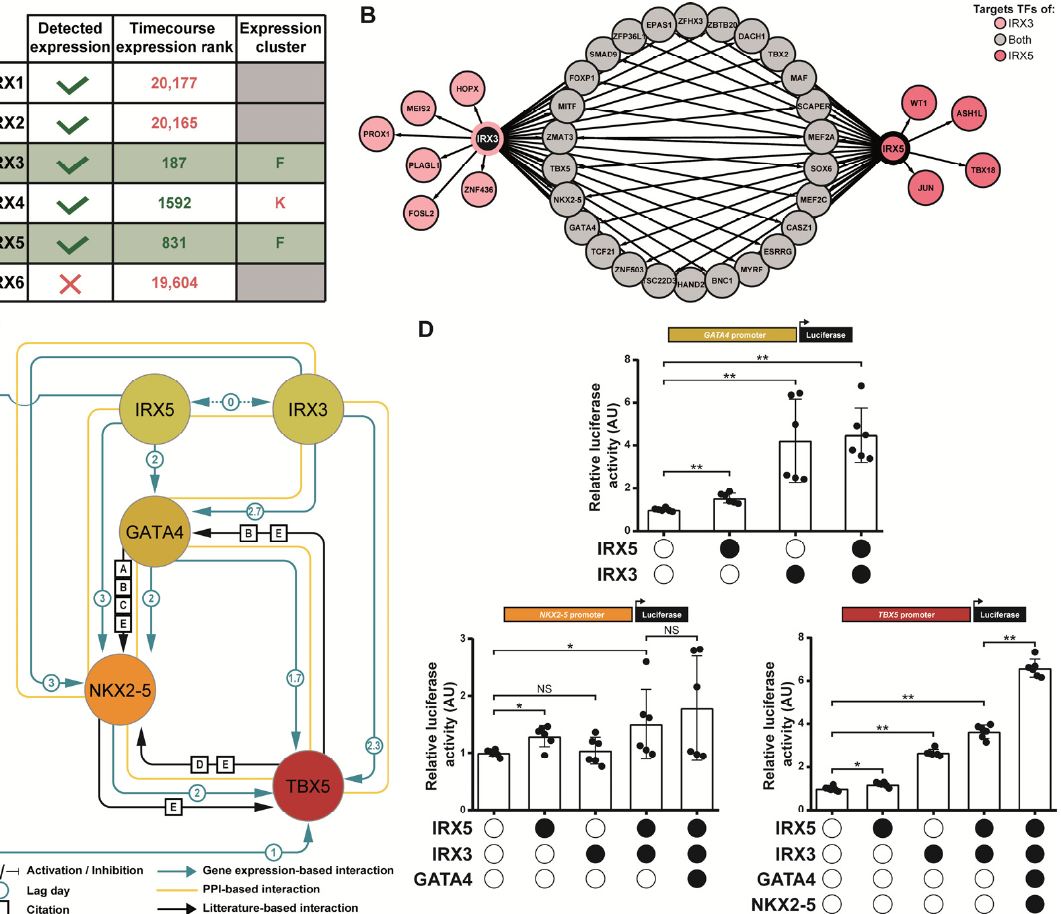
Figure 5. Exploration of the inferred IIGNT sub ‐ network. ( A ) Table of TF selection criteria for the IRX genes family. Timecourse expression rank is the output of the timecourse package and illustrates the variation in gene expression during directed cardiac differentiation (a lower number indicating a higher variation). The Expression cluster column refers at the expression cluster in which each TF ranged as in Figure 4A. Selection and exclusion criteria are indicated in green and red re ‐ spectively. ( B ) Potential target TFs of IRX3 and/or IRX5 identified in the G ‐ to ‐ L clusters based on the gene expression ‐ based network. ( C ) Gene expression ‐ based network of IRX3, IRX5, GATA4, NKX2 ‐ 5 and TBX5 TFs. Node colors represent their corresponding clusters as in Figure 4A: IRX3 and IRX5–cluster F; GATA4–cluster G; NKX2 ‐ 5–cluster I; TBX5–cluster L. Lag is shown in days. References to literature ‐ based links: [A] Book chapter DOI: 10.1016/B978 ‐ 0 ‐ 12 ‐ 381332 ‐ 9.00027 ‐ X.; [B] PMID: 23457256; [C] PMID: 22449847; [D] PMID: 32450132; [E] PMID: 25280899. ( D ) Graphs displaying activity levels of luciferase that is under the control of GATA4 ( ‐ 1800_TSS_+200), NKX2 ‐ 5 ( ‐ 2000 bp_Start codon) and TBX5 ( ‐ 1800_TSS_+200) promoter constructs. Mean +/ ‐ SD; * and **: p < 0.05 and p < 0.01, respectively (Mann ‐ Whitney test). In order to investigate the role of IRX3 and IRX5 in cardiac differentiation progres ‐ sion, all their potential TF targets in the subsequent G to L clusters were extracted from the gene expression ‐ based network (Figure 5B). Interestingly, this analysis revealed pre ‐ viously unknown regulatory links between cardiac TFs. Indeed, the master cardiac TF genes GATA4 (cluster G), NKX2 ‐ 5 (cluster I) and TBX5 (cluster L) were individually found to be potential targets of both IRX3 and IRX5. It is well established that GATA4 acts in a multiprotein complex with NKX2 ‐ 5 (cluster I) and TBX5 (cluster L) cardiac TFs [6,35,36]. To further explore the potential new interactions, we then focused on the gene expression ‐ based sub ‐ network involving IRX3, IRX5, GATA4, NKX2 ‐ 5 and TBX5, sub ‐ sequently referred to as the IGNiTe sub ‐ network (Figure 5C). In the IGNiTe sub ‐ network, IRX3 and IRX5 were inferred as activators of GATA4 , NKX2 ‐ 5 and TBX5 , and confirming the literature [5,37–39], GATA4 was inferred as an activator of NKX2 ‐ 5 and both GATA4 and NKX2 ‐ 5 were activators of TBX5 expression.